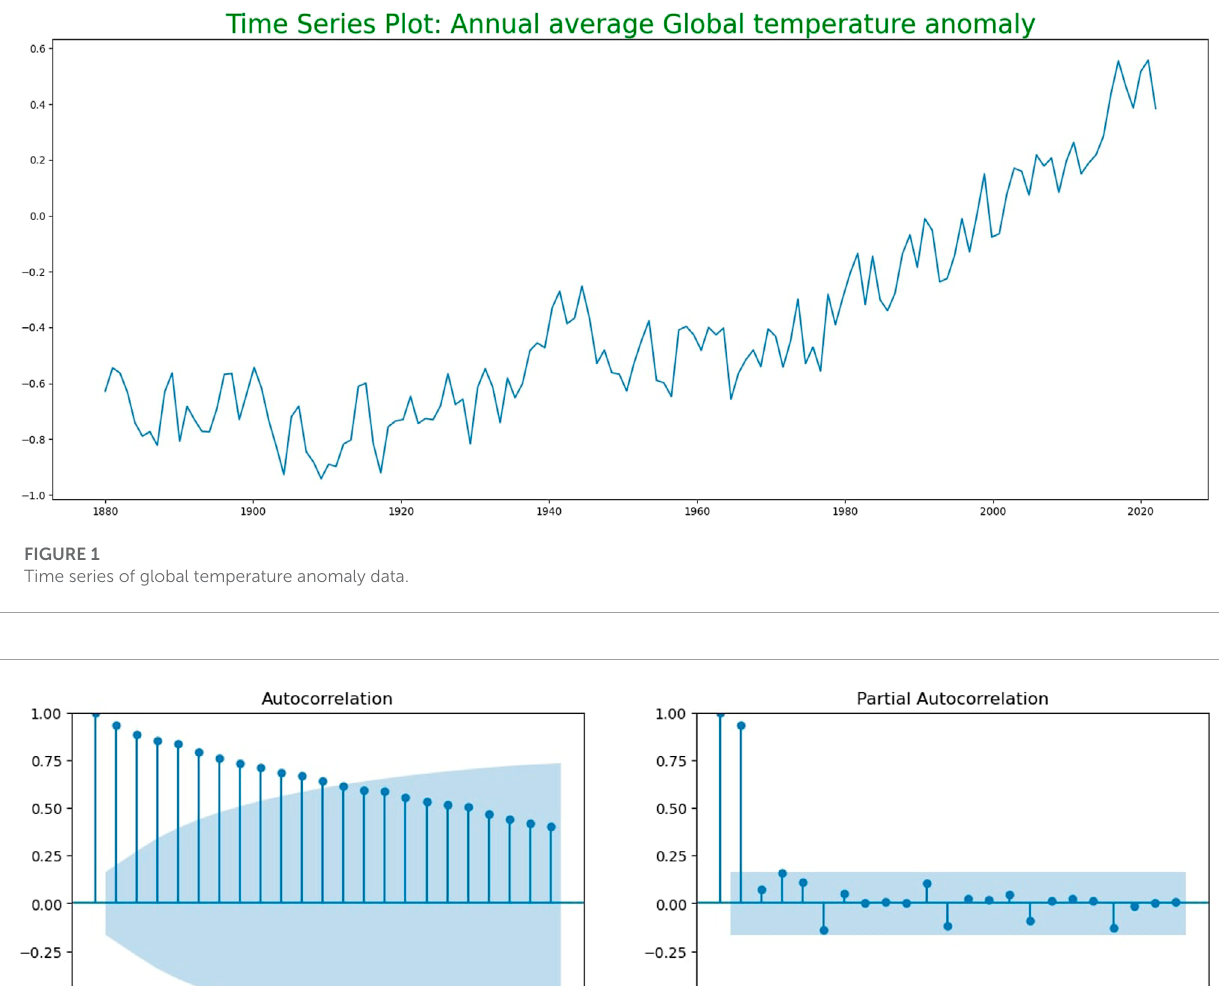
FIGURE 2 ACF and PACF for global temperature data. (A) Autocorrelation functions for global temperature data. (B) Partial autocorrelation function.